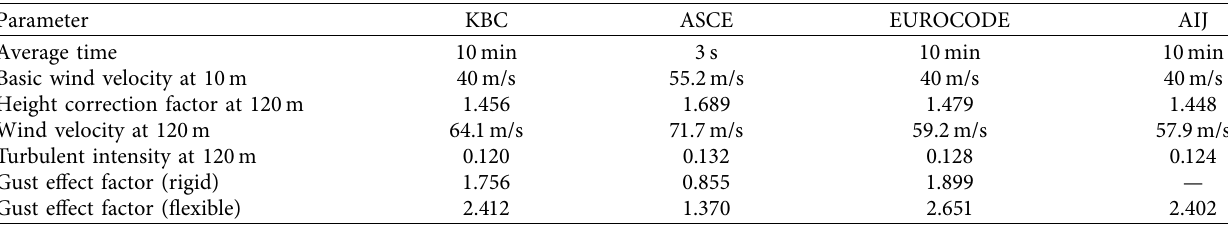
Figure 14: Vertical profile of wind velocities and turbulent intensities on flat open terrain. (a) Height correction factor. (b) Turbulent intensity. Table 3: Wind velocities and gust effect